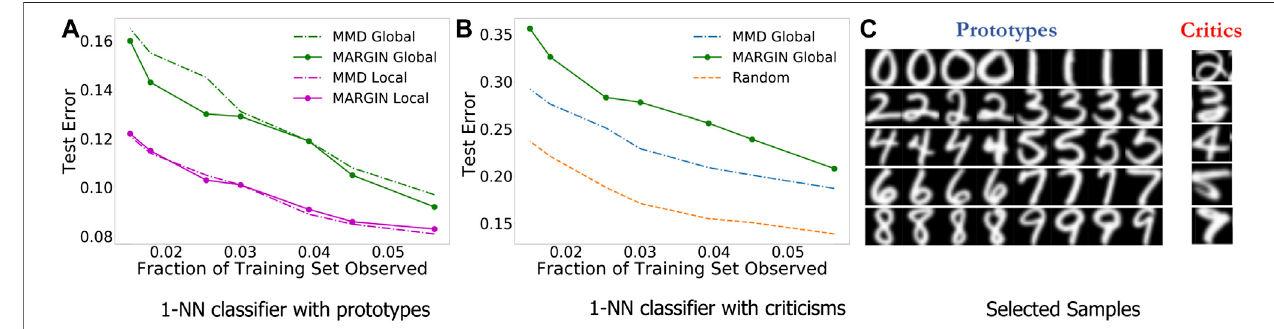
FIGURE2| Using MARGIN tosampleprototypesandcriticisms. Inthisexperiment, westudythegeneralization behaviorofmodels trainedsolely usingprototypes or criticisms.